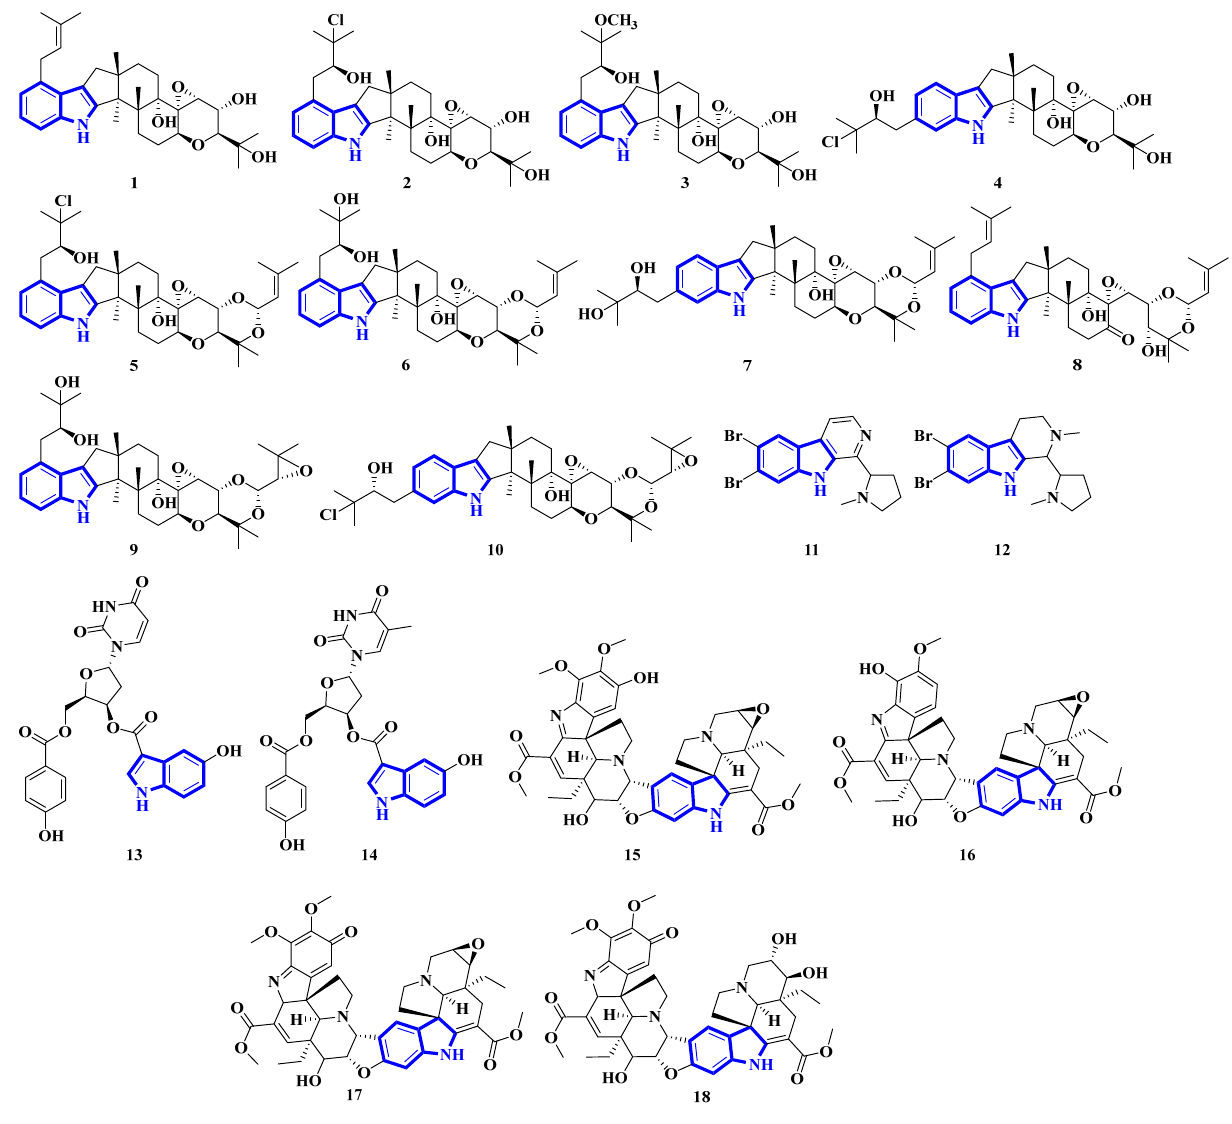
Figure 3. Novel indole alkaloids 1 to 18 . Compounds 19 to 23 were isolated from Aphanoascus fulvescens , obtained from goose dung, and represent okaramine-type bisindoles (Figure 4) [23]. Compounds 24 to 29 are indole diterpenoids in which compound 24 is a new scaffold with a rare carbazole unit form- ing a 6/5/6/6/6/6/5 heterocyclic system bearing an aromatic ring C [24]. Compounds 30 and 31 are izumiphenazine A-type alkaloids containing a novel 5-hydroxyquinoxaline and alpha-keto acid motif [25]; however, compounds 32 to 36 are chlorinated cyclic hexapep- tides. Unfortunately, the structure of compound 34 could not be completely resolved since minute amounts of it were isolated ( 34a and 34b ) [26]. Compounds 37 to 39 were isolated from the stem bark of Kopsia arborea . Compound 37 is an unusual pentacyclic monoter- penoid alkaloid with a new carbon–nitrogen skeleton. Furthermore, compounds 38 and 39 are pentacyclic corynanthean-type alkaloids that contain a hydroxyethyl-substituted tetrahydrofuranone ring [27]. Compounds 40 and 42 are bisindoles, with the former having a β -carboline motif. Compounds 44 and 45 are demethylated derivatives of chaetogline A and F (demethylation on 19-O and 20-O, respectively) [28]. Compounds 46 to 50 were